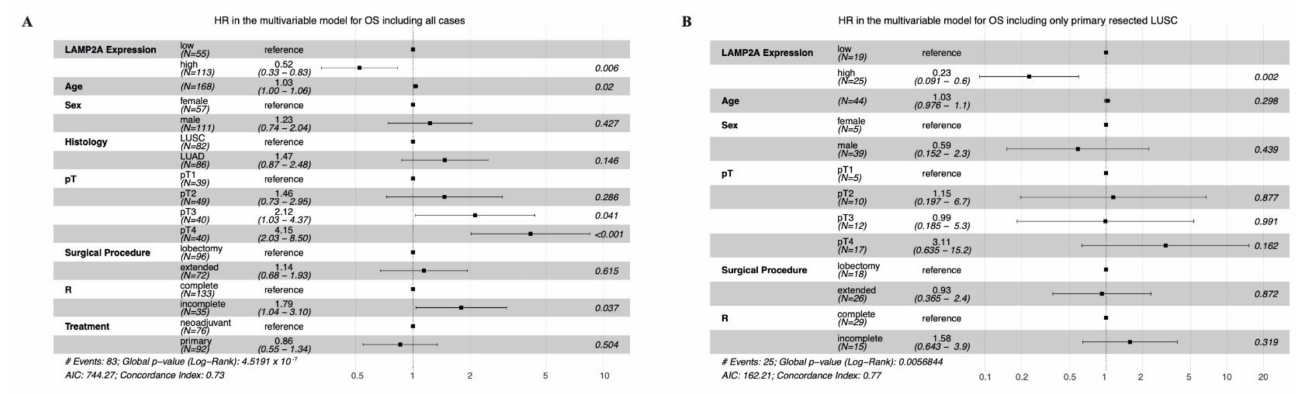
Figure 5. Multivariable analysis ( A ) OS, including all cases; ( B ) OS, primary resected LUSC. LUSC: Lung squamous cell carcinoma, LUAD: Lung adenocarcinoma, Extended: Pneumonectomy or